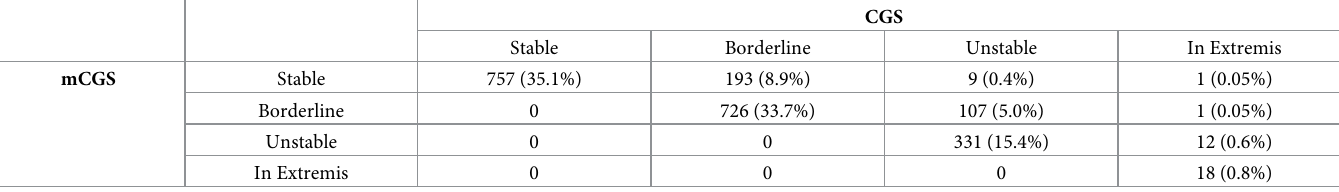
Table 3. Changes in patient risk assessment by modification of the CGS to the mCGS.